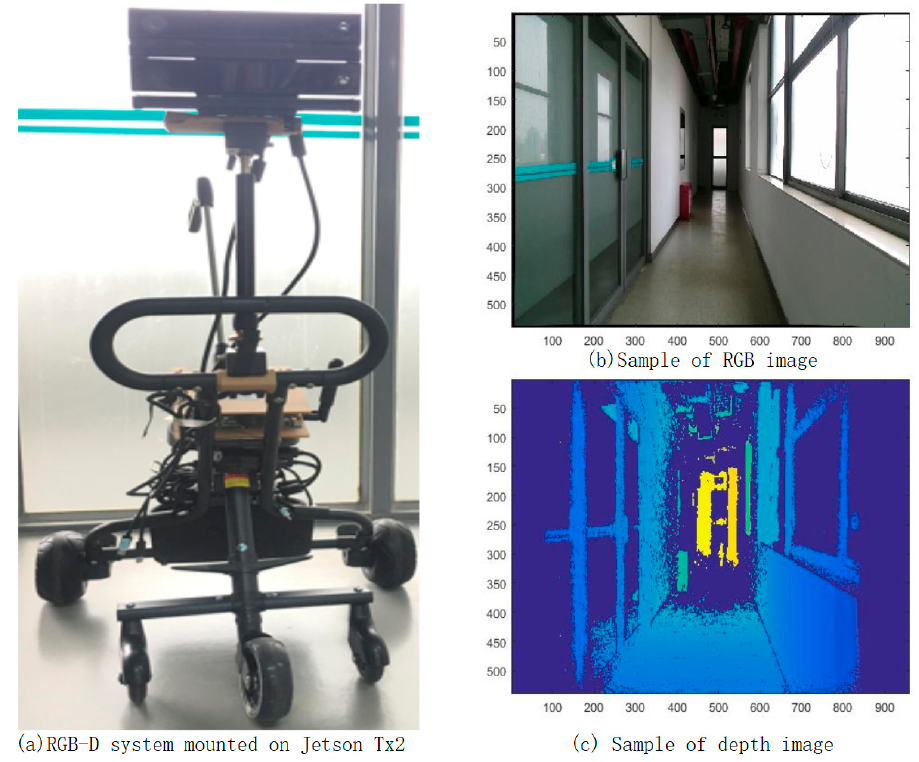
Figure 11. RGB-D system of data collection.